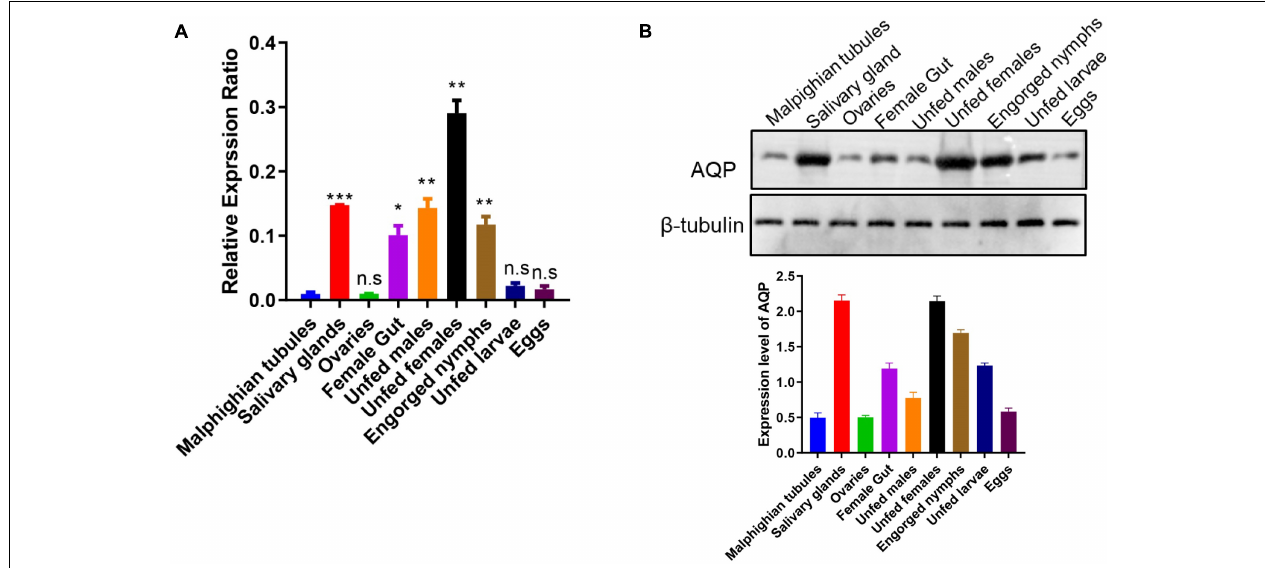
FIGURE 6 | Expression of the H. qinghaiensis AQP ( HqAQPs ) in dissected tick tissues and different life stages. (A) The transcription level of HqAQP1 was determined by RT-qPCR in Malpighian tubules, salivary glands, ovaries, female guts, unfed males, unfed females, engorged nymphs, unfed larvae, and eggs using HqAQP1 -specific primers and was calculated as relative quantity using the delta Ct, normalized to the total amount of RNA. All experiments were independently conducted at least three times. Statistical significance is denoted by * p < 0.05, ** p < 0.01, *** p < 0.001. (B) Western blot measurement of the pattern of expression of HqAQP1 in different tick life stages and tissues.